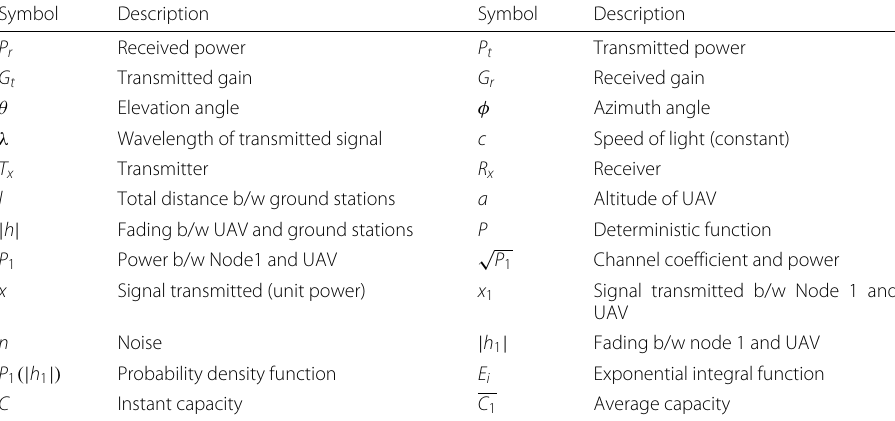
Table 2 Mathematical terms and